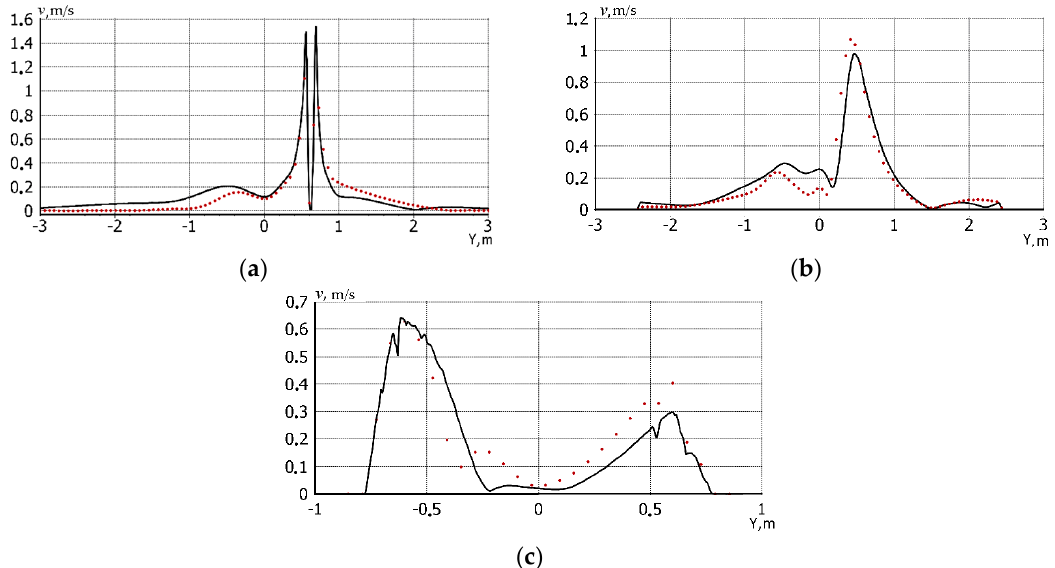
Figure 7. Graphs of the velocity distribution along the Y axis: ( a ) with Z = − 70 mm; ( b ) with Z = − 715 mm; ( c ) with Z = − 1320 mm.